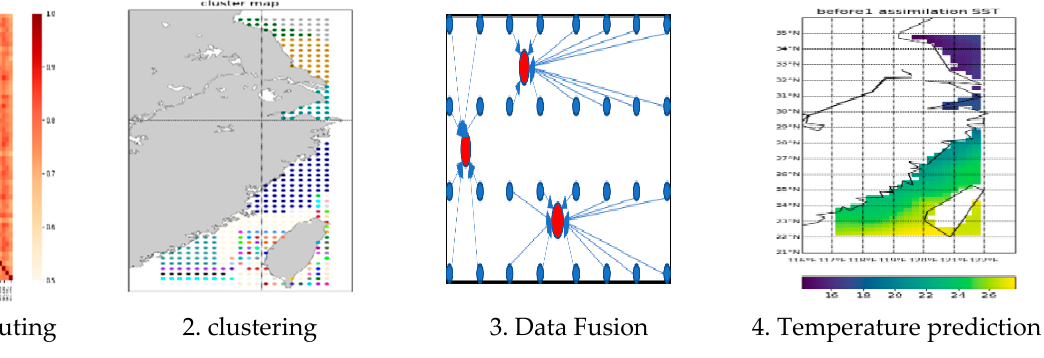
Figure 1. Data processing.